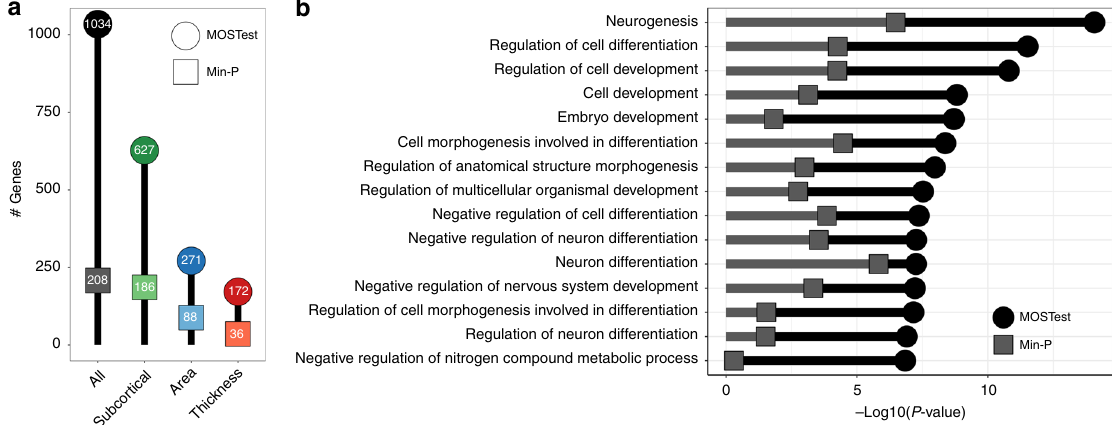
Fig. 4 Functional mapping and annotation indicates high neurobiological relevance. a Number of genome-wide signi fi cant genes identi fi ed (on the y axis and in the bubbles) for each set of features (on the x axis), by MOSTest (in darker colored circles) and by min-P (in lighter colored squares). b Results from the gene-set analyses following the application of MOSTest and min-P on all brain features. The 15 most signi fi cant Gene Ontology sets for MOSTest are listed on the y axis and − log10( p -values) are shown on the x axis. Multiple-comparisons corrected MOSTest gene-set p -values are indicated by black circles, min-P in gray